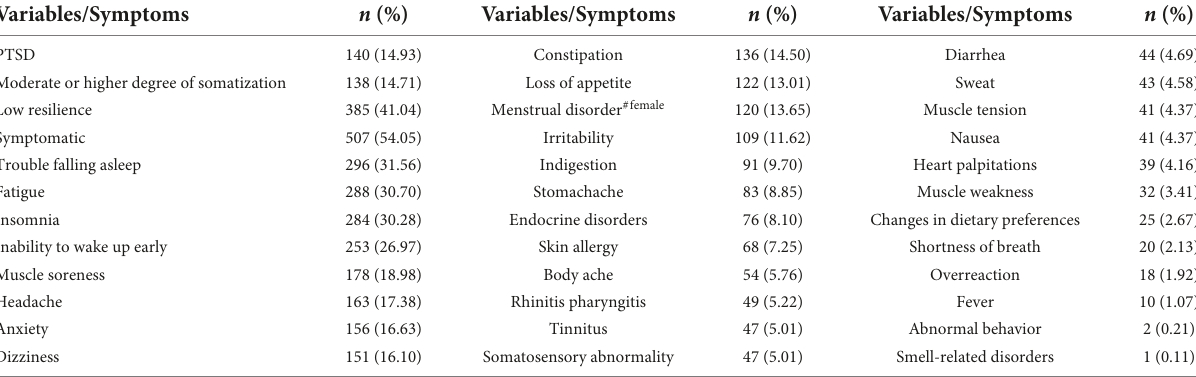
TABLE 2 Variables and symptoms among frontline healthcare professionals ( n =